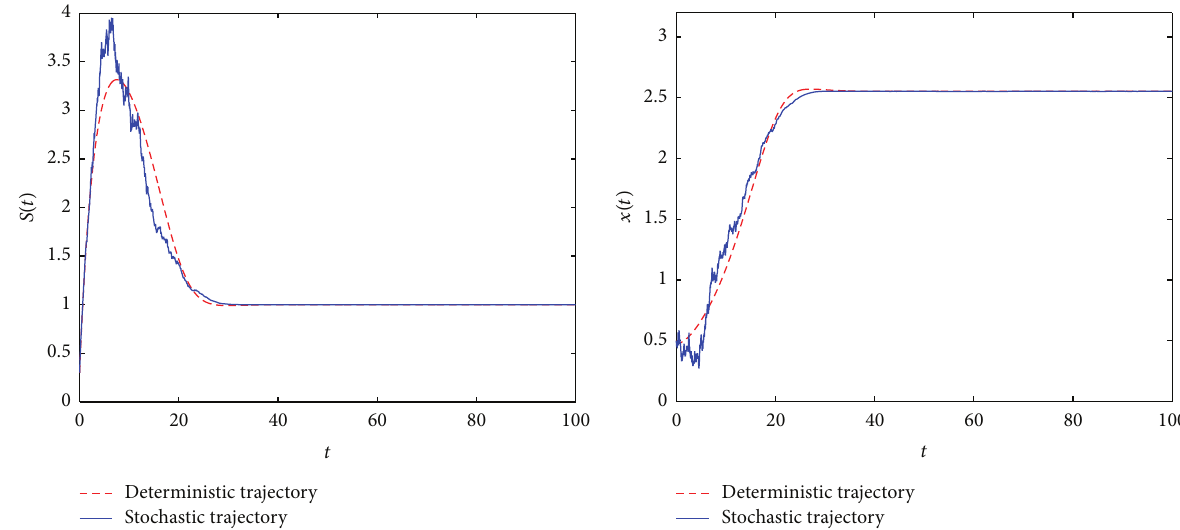
Figure 1: The dynamics of stochastic model compared with deterministic model with 𝜎 1 = 0.1 and 𝜎 2 = 0.08 . Here 𝑆(0) = 0.3 , 𝑥(0) = 0.5 .